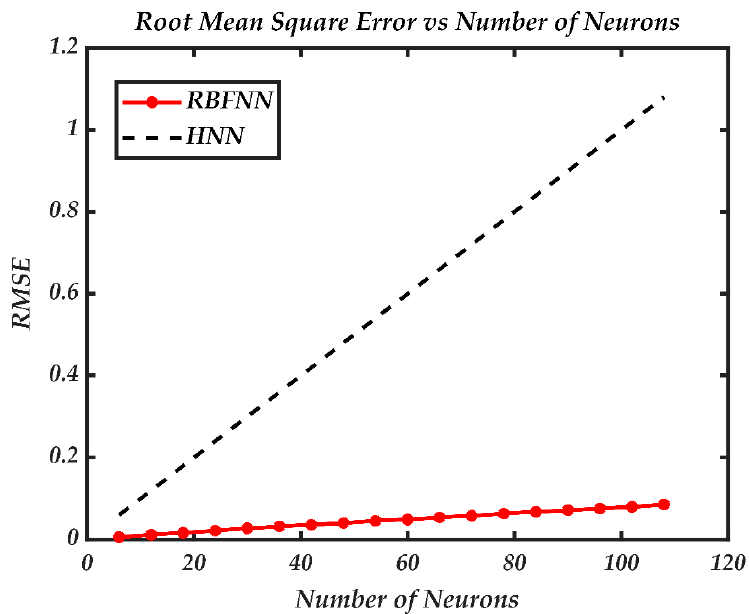
Figure 3. The performance of proposed RBFNN and Hopfield Neural Network (HNN) in term of Root Mean Square Error (RMSE).